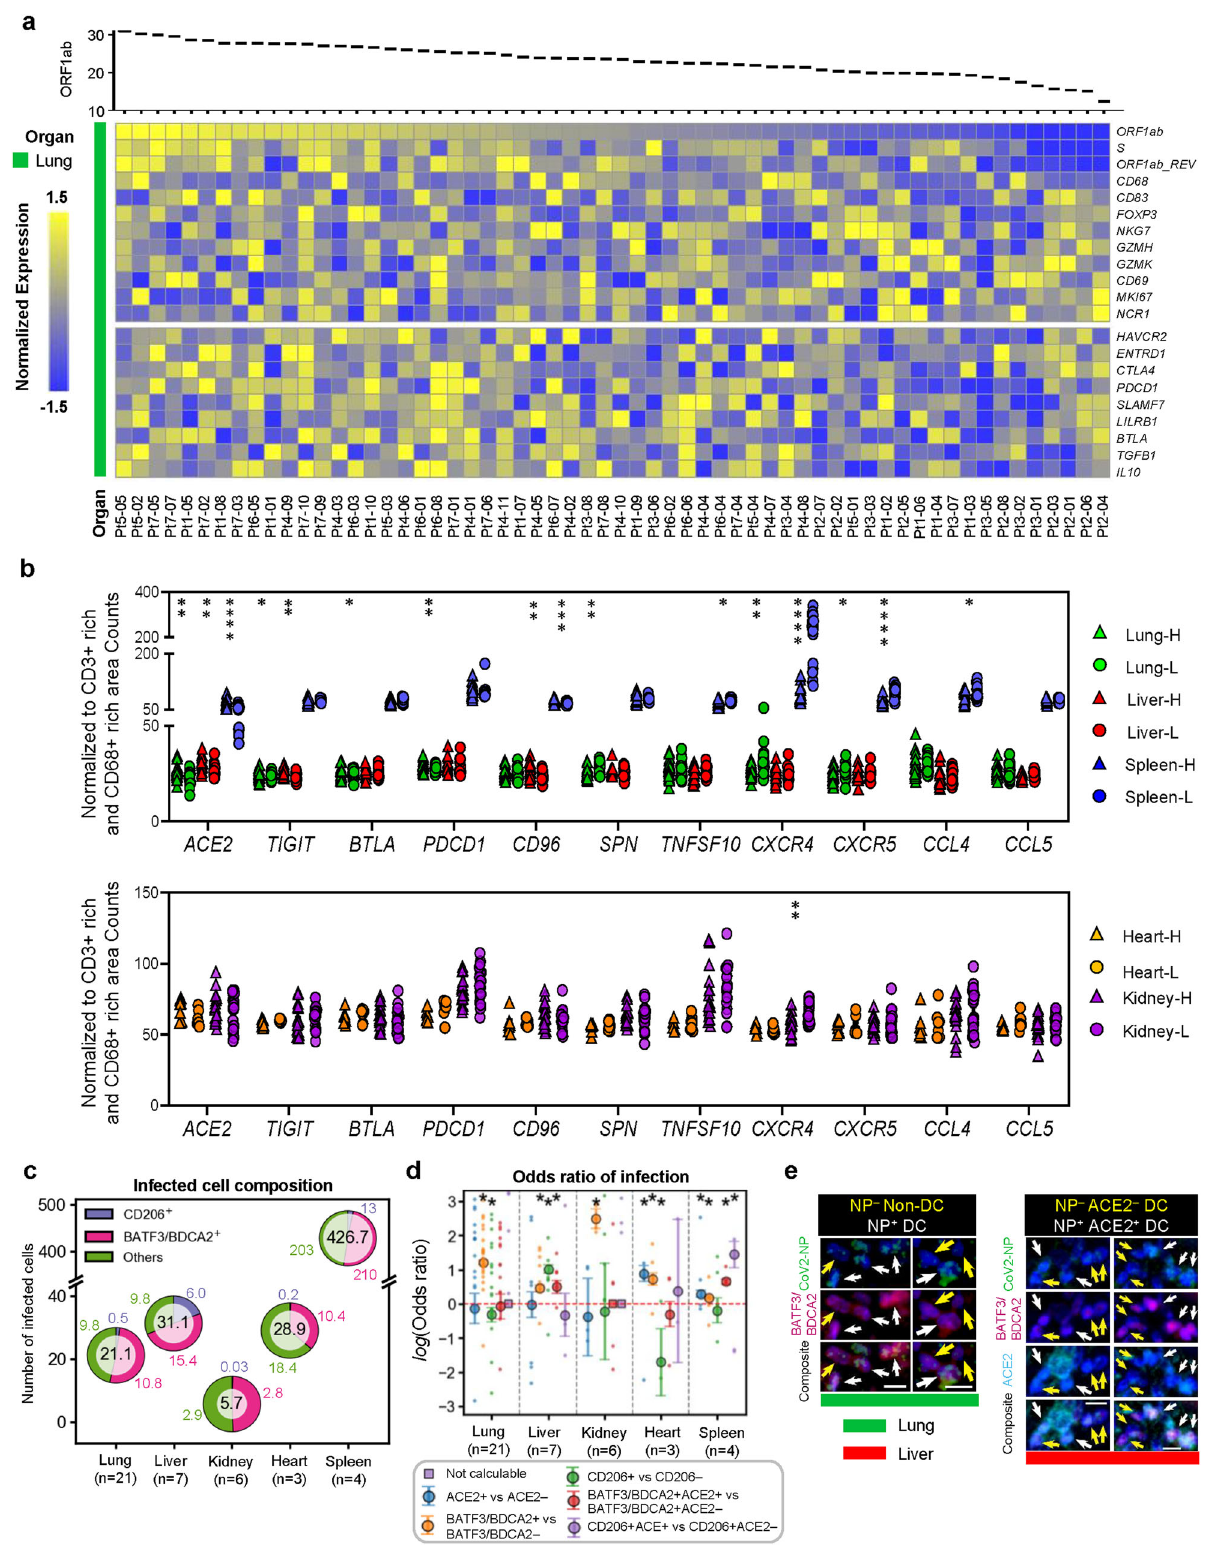
(version2.38.1), clusterPro fi ler (version3.14.3), pathview (version1.26.0), Annota- counted within exons using FeatureCounts (v2.0.1) with default parameters to generate tionHub (version2.18.0), org.Hs.eg.db (version3.10.0), tidyverse (version1.3.0), GSEA- the expression matrices of the raw read counts. For the raw data, the rowSums () Base (version1.48.0), Rgraphviz (version2.30.0), showtext (version0.9), readr function in the base package was used that fi lters out data with read counts < 2. The (version1.3.1), stats (version3.6.1), enrichplot (version1.6.1). Ggplot2 (version3.3.2), DESeq2 (v1.26.0) and edgeR (v3.28.1) package in Rstudio (https://rstudio.com/) was ggrepel (version0.8.2), RcolorBrewer (version1.12) were used drawing and color used to identify differentially expressed genes. All analyses were performed in R (https:// matching. TrimGalore (https://github.com/FelixKrueger/TrimGalore/issues/25) was www.r-project.org/;v3.6.1). Heat maps were drawn using Pheatmap(v1.0.12) and the used for data QC to remove joints in the pre-processing. GSEA and GO analysis of the enriched genes was performed using topGO NATURE COMMUNICATIONS| (2022) 13:269